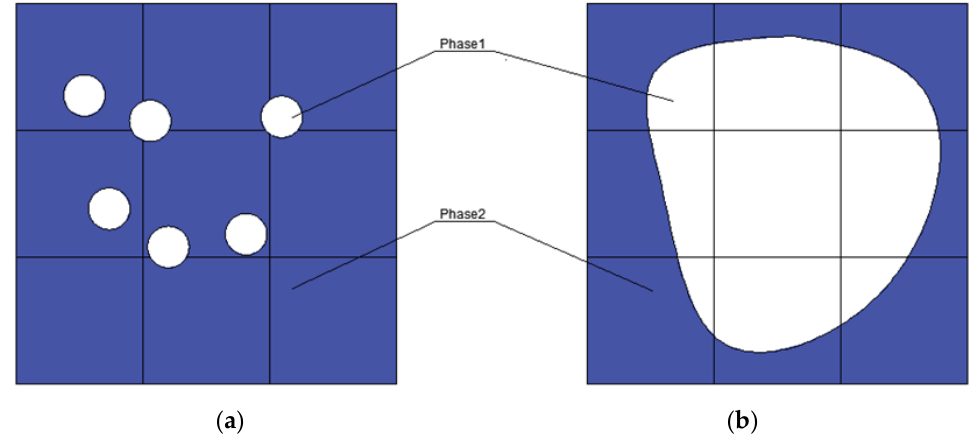
Figure 1. ( a ) unsuitable mesh size; ( b ) suitable mesh